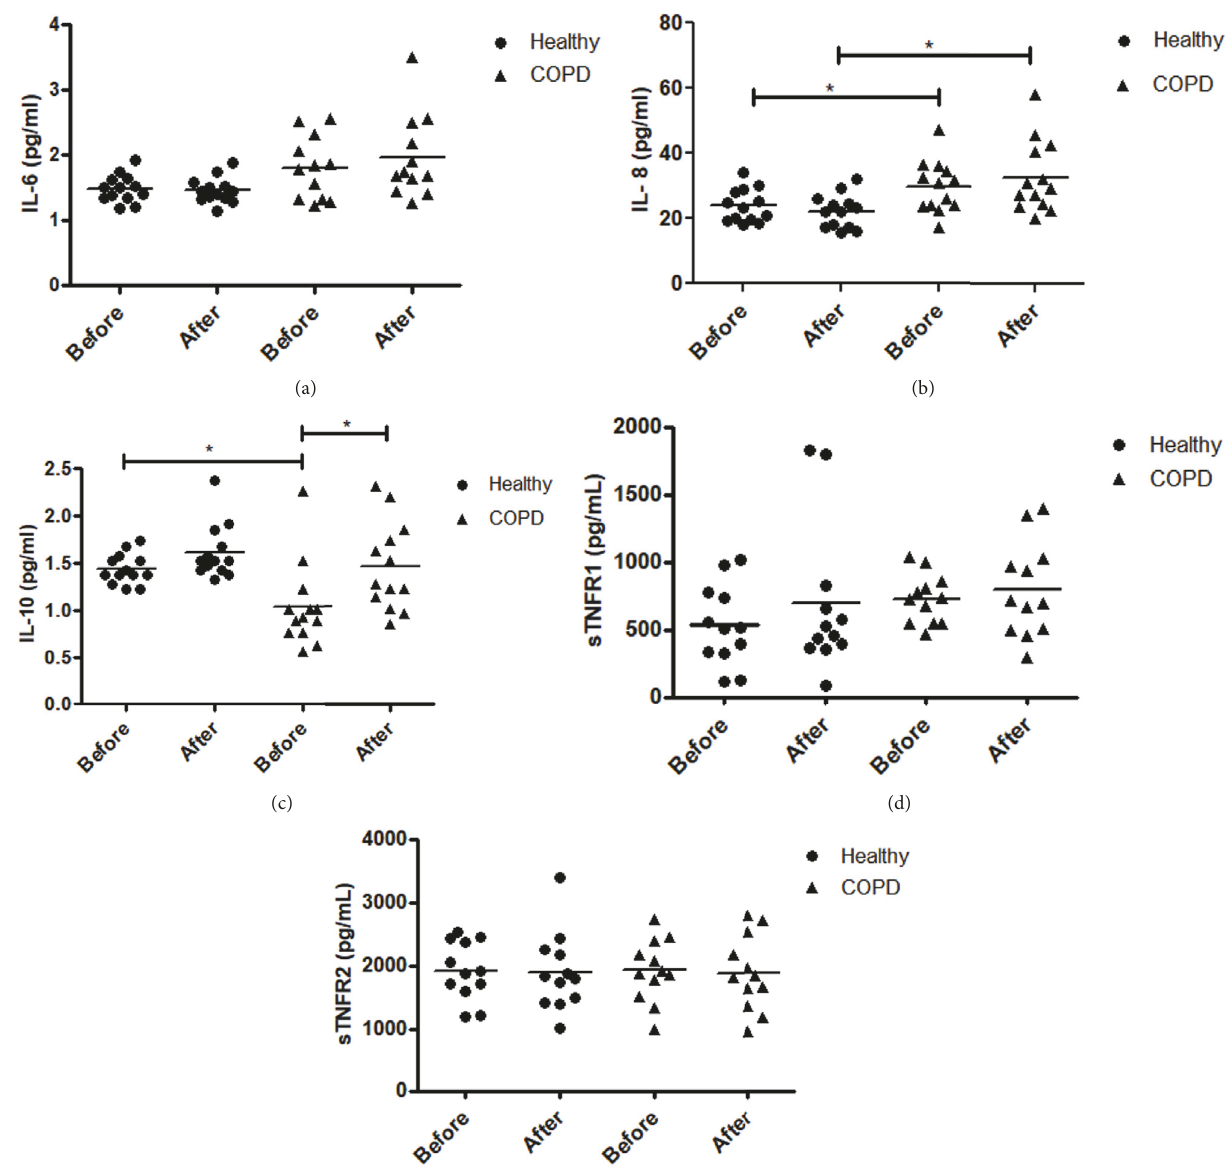
Figure 1: Comparison of WBV for healthy and COPD participants on plasma levels of IL-6 (a), IL-8 (b), IL-10 (c), sTNFR-1 (d), and sTNFR-2 (e) . Means ± SD. Two-way ANOVA and post hoc t -test. Difference between groups ( ∗ ) and difference between pre- and post-WBV ( ∗∗ ); COPD: chronic obstructive pulmonary disease; IL-6, IL-8, and IL-10: interleukin 6, interleukin 8, and interleukin 10; sTNFR1 and sTNFR2: soluble tumor necrosis factor receptors 1 and